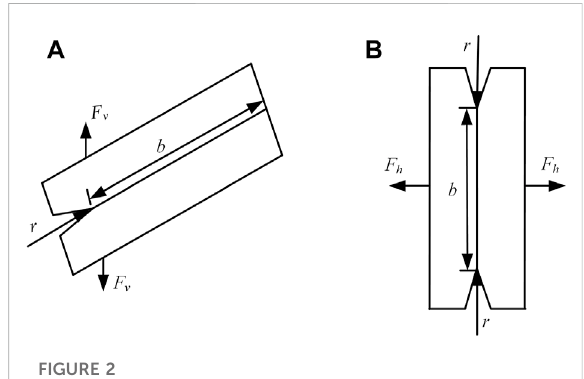
FIGURE 1 Sketch of progressive failure of the slope.